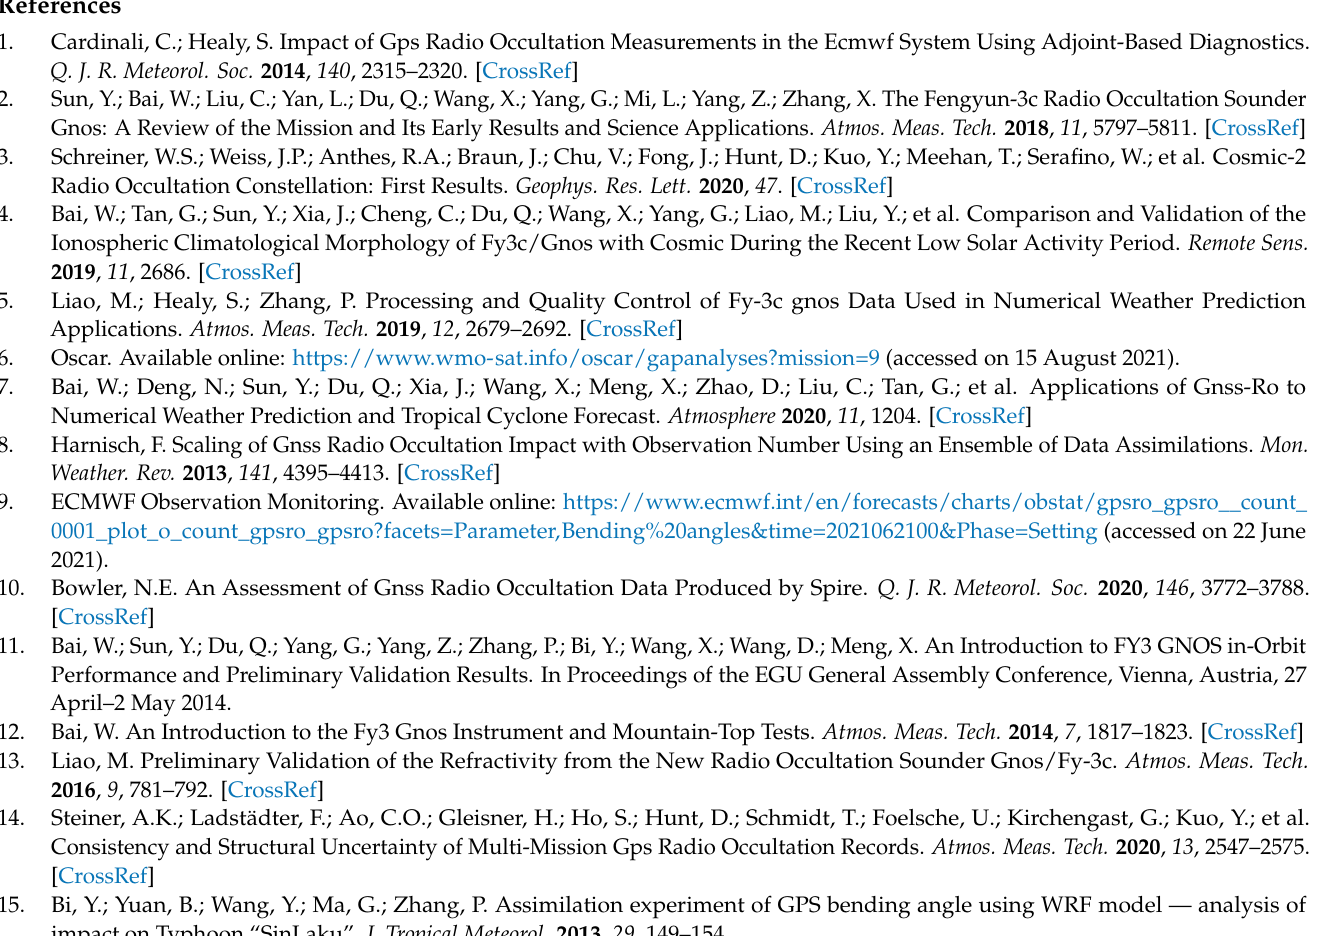
Figure A8. Mean value of refractivity profiles’ relative difference (RD), ( E − T ) /T, between FY3D (True value, T) and EC4Dvar (Experimental value, E). There are large differences at the heights of 18 (0.3%), 48 (1.3%), 58 (3.1%), 78 (10%) km. ( a – c ) shows the mean value of it.